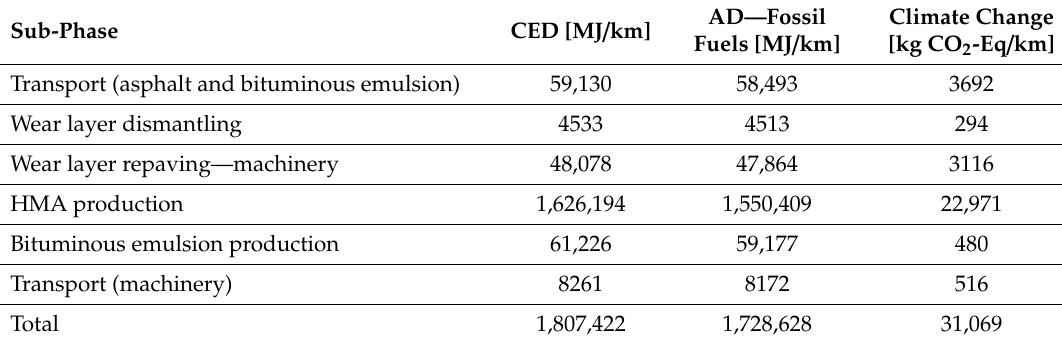
Table 12. The impacts of the wear layer